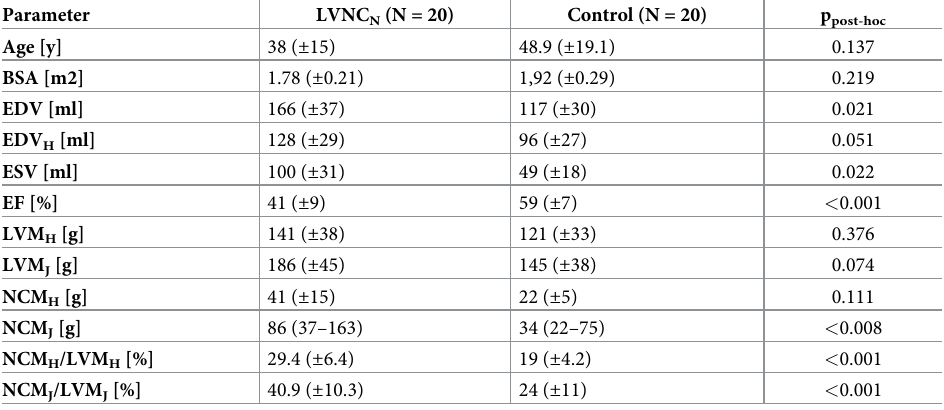
Both the NCM or NCM revealed a good and similar correlation concerning EDV in the H J overall examined group (r = 0.789, p < 0.001 vs. r = 0.799, p < 0.001; respectively), the LVNC Table 5. Comparison of left ventricular noncompaction subgroup with normal-range left ventricle (LVNC N ) and the control group.